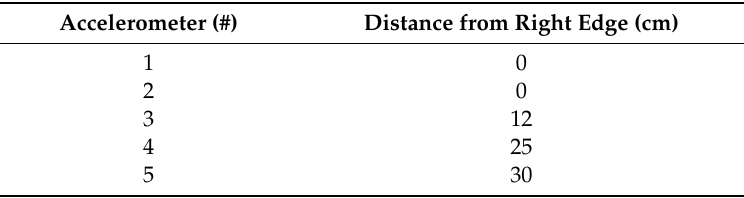
Table 2. Accelerometer positions.